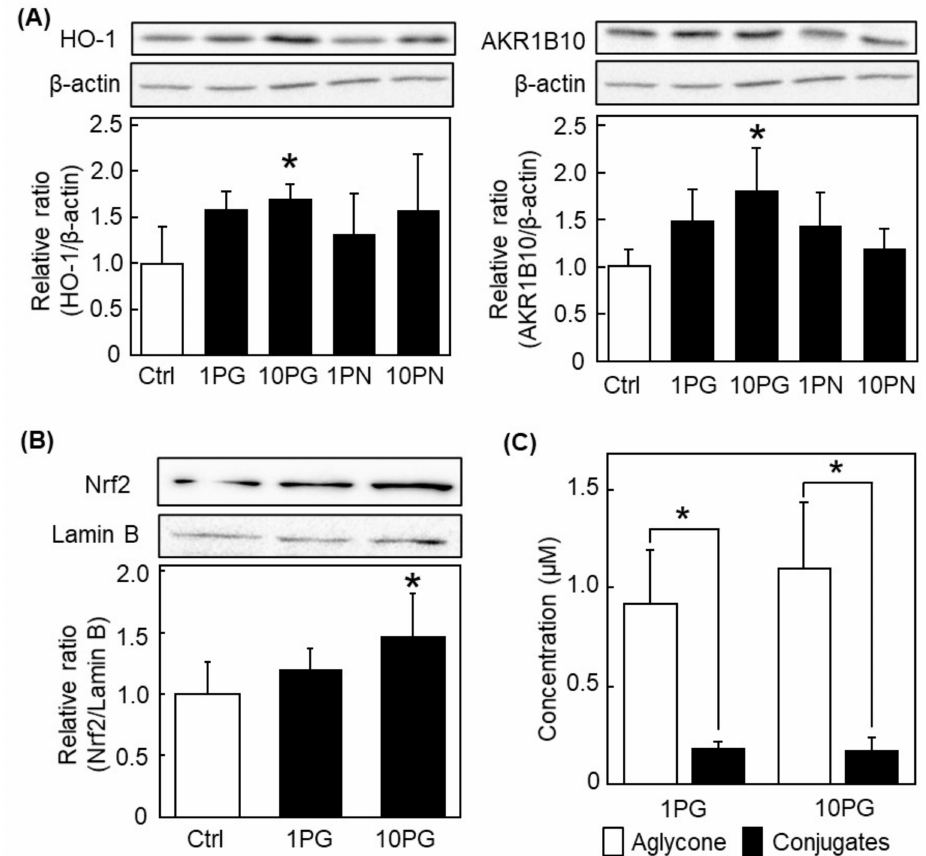
Figure 6. Induction of antioxidant enzymes in the liver of PG-administered mice and the concentration of incorporated PG in the plasma. Male ICR mice were orally administrated PG at 1.0 (1PG) or 10 mg/kg body weight (10PG) once a day for 1 week. The protein expression level of ( A ) HO-1 and AKR1B10 and ( B ) nuclear translocation of Nrf2 was determined by western blotting. Upper panels show typical blot data, while bottom ones are the intensity of specific bands after normalizing data by the β -actin (for ( A )) and Lamin B (for ( B )) levels. Values are the mean ± SE ( n = 6), * p < 0.05 vs. control by Dunnett’s multiple comparison test. ( C ) The plasma concentrations of PG aglycon and conjugates were determined by HPLC. Values are the mean ± SE ( n = 3), * p < 0.05 vs. control by student’s t